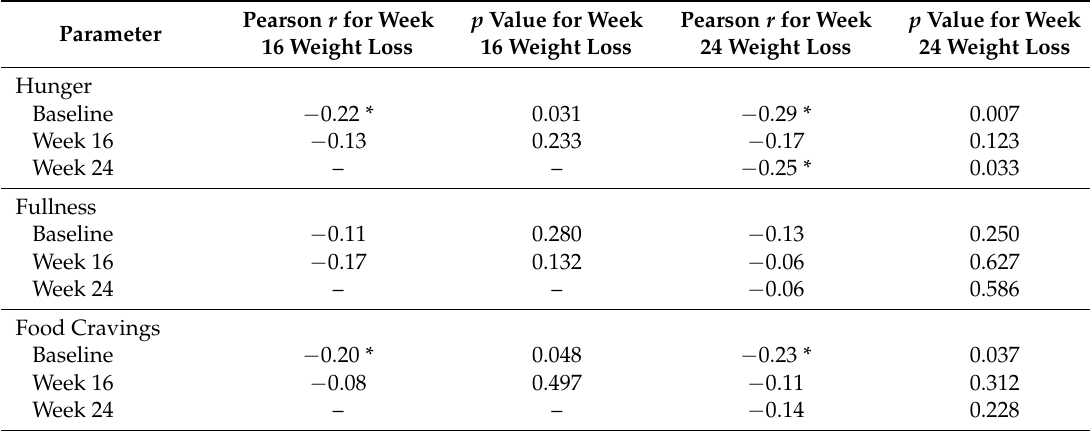
Figure 2. Changes in hunger ( A ), fullness ( B ), and cravings ( C ) during the Beef WISE Study. Hunger was reduced in both groups at weeks 8 and 24 compared to baseline, and also at week 16 in B. Fullness during weight loss was not different from baseline. Cravings were reduced in B at all intervention time points compared to baseline, and were reduced in NB at week 8 but not weeks 16 or 24. * Indicates significantly different from baseline ( p < 0.05) by linear mixed model analyses (SAS, Proc Mixed). Table 2. Correlations of hunger, fullness, and food cravings with weight loss.